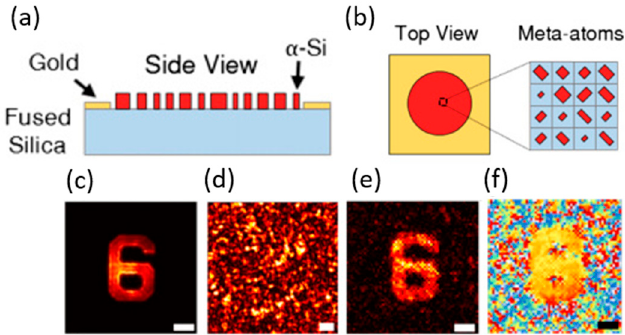
Figure 11. Metasurface-based computational imaging process. ( a ) Schematic illustration of the side view of the MD. ( b ) Schematics of a uniform array and unit cell of the metasurface, showing the parameter definitions. The transmission phase of the two orthogonal polarizations can be manipulated using the meta-atoms. ( c ) In-focus images of targets captured by a custom-built microscope. ( d ) The resulting speckle patterns of the samples after passing through the MD. ( e ) The retrieved object amplitudes. ( f ) Phases from the captured speckle patterns. The scale bars are 25 µm. (Reproduced from [64] with permission.)